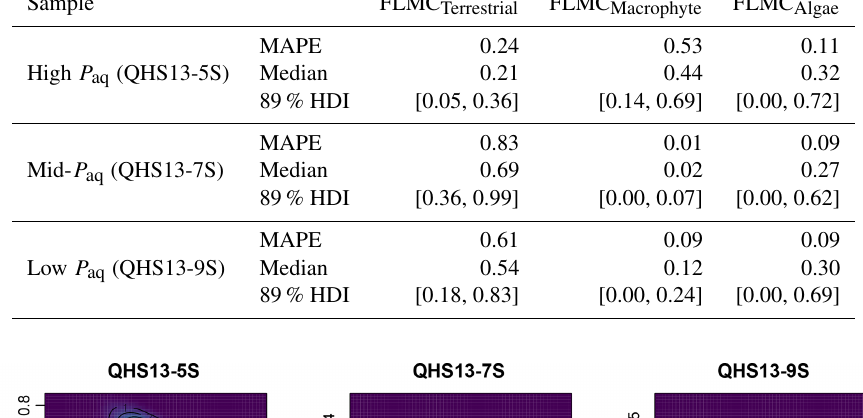
Table 3. The maximum a posteriori probability estimates (MAPE), the medians, and the 89% highest density intervals (HDI) of posterior